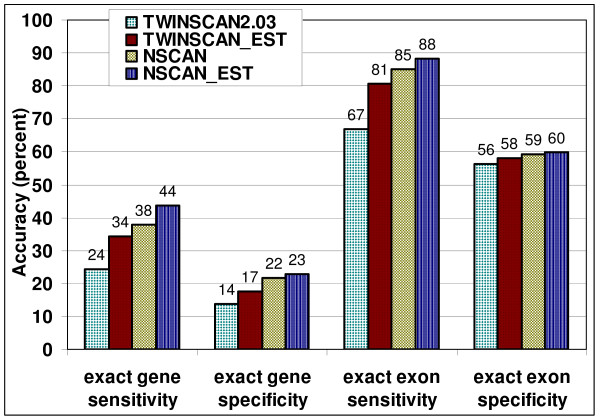
Accuracy of TWINSCAN, TWINSCAN_EST, NSCAN and N-SCAN_EST on the human genome. For TWINSCAN and TWINSCAN_EST, the mouse genome sequence is used as the informant database. For NSCAN and N-SCAN_EST, mouse, rat and chicken genomes are used as the informant databases. Human ESTs are from dbEST. For all methods, pseudo genes are masked out first [41].